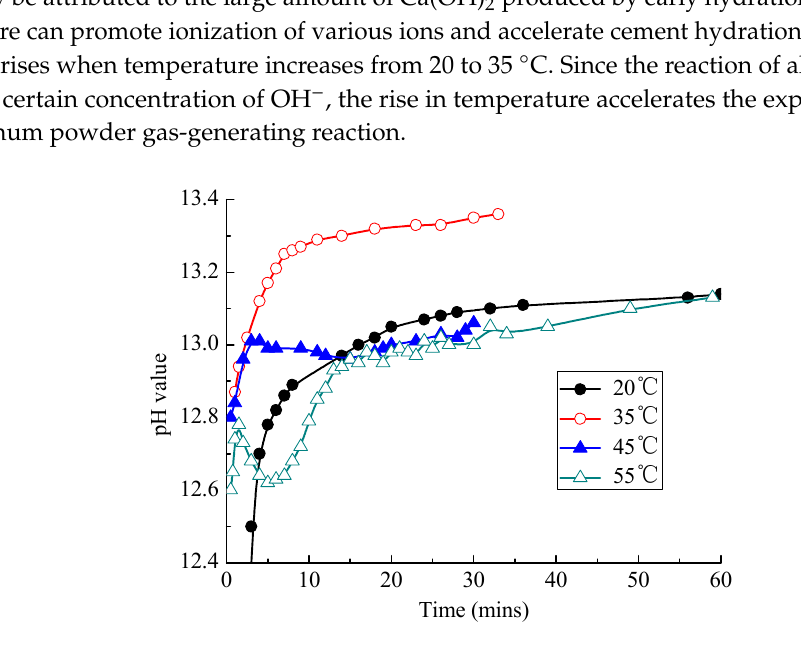
Figure 11. E ff ects of temperature on changes of pH value of CAM-I with Figure 11. Effects of temperature on changes of pH value of CAM-I with time.